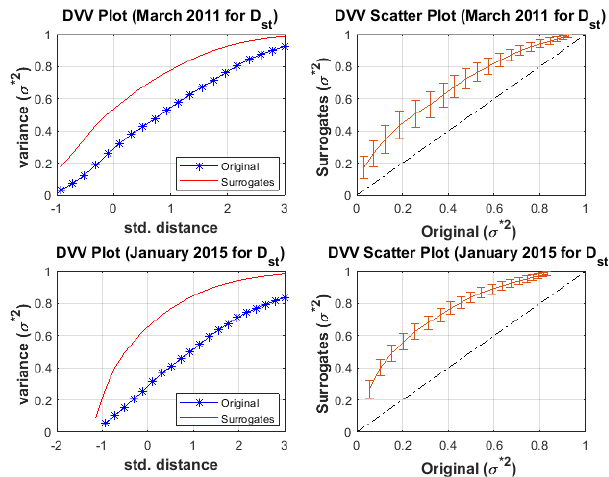
Figure 8. The DVV plot and scatter plot for D st during moderate geomagnetic storm for March 2011 and January 2015.